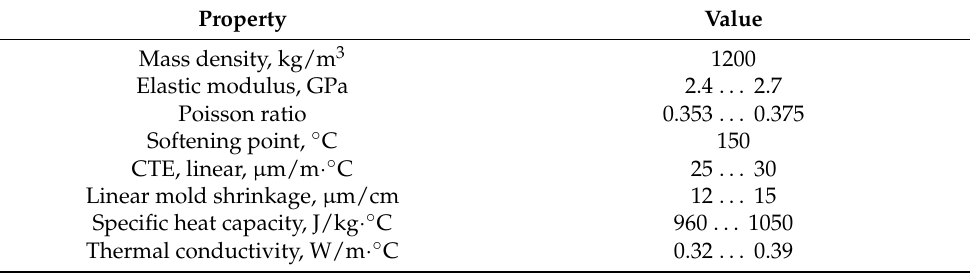
Table 2. Physical and mechanical properties of post-cured epoxy resin.